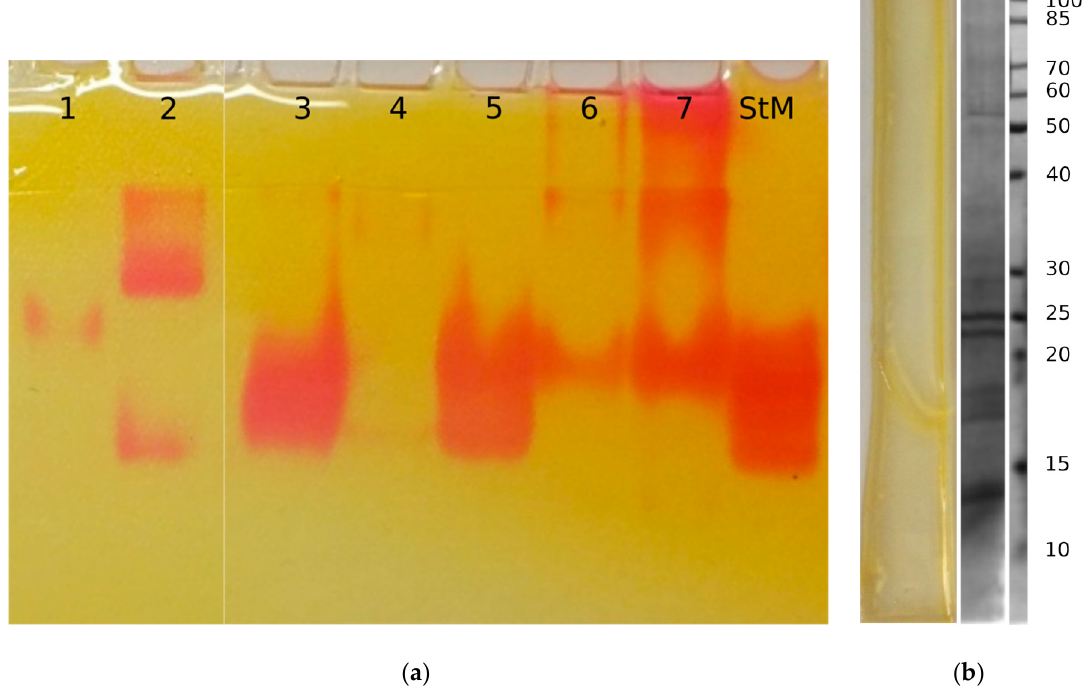
Figure 3. On-gel detection reaction of myrosinases from crude extracts of different species of Brassicaceae. Subplots: ( a ) Crude extracts with 80 µg protein content were loaded on 7.5% native PAGE. Samples: 1: Brassica oleracea var. gemmifera buds; 2: Brassica oleracea var. italica flowering heads,